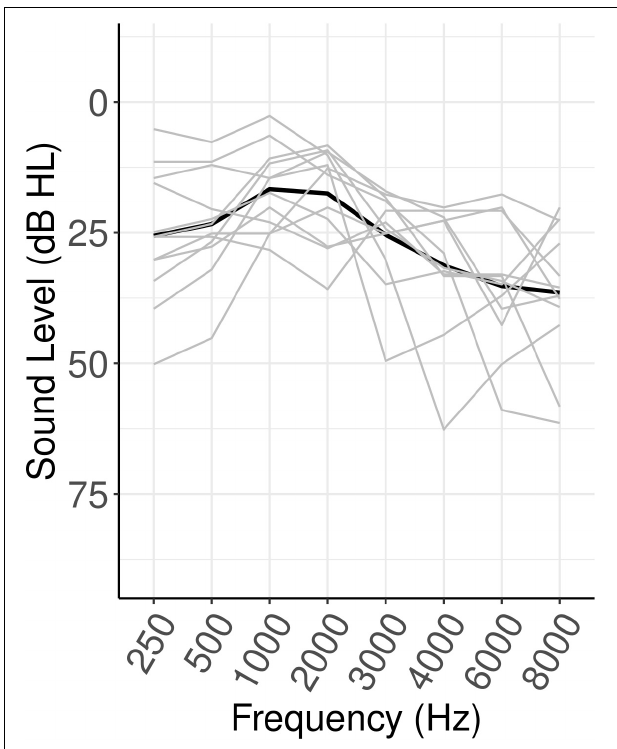
FIGURE 1 | Hearing levels of participants. Black line shows the mean, gray lines show individual